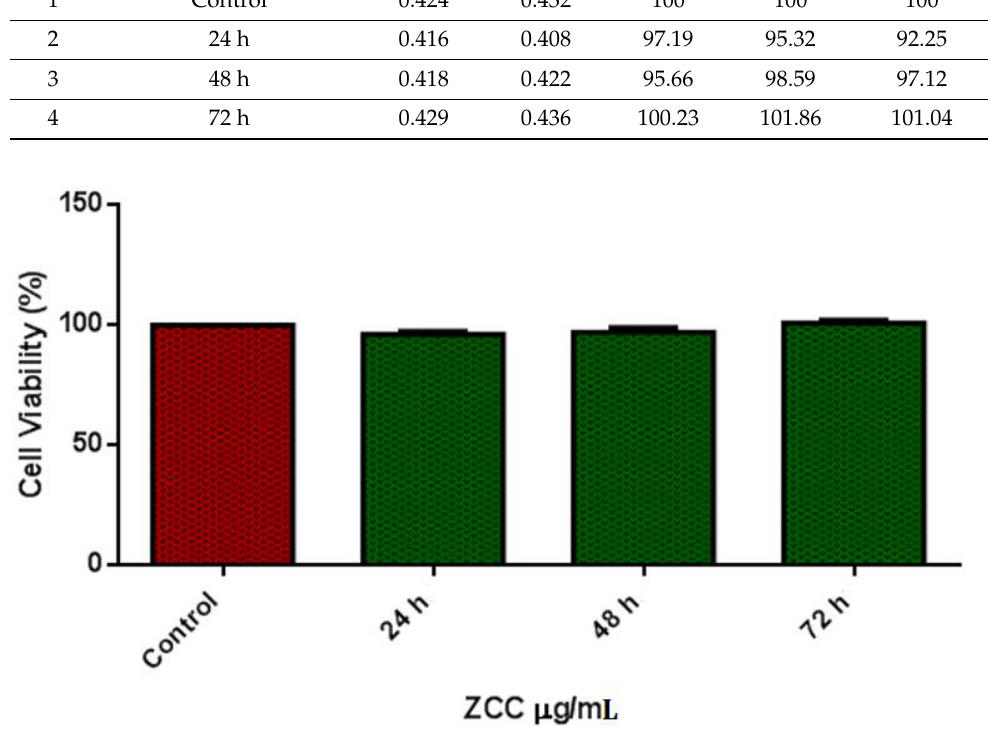
Figure 7. Cell viability – Vero cell